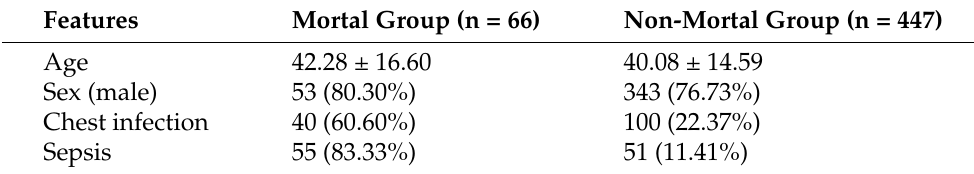
Table 4. Distribution of features in the mortal and non-mortal groups, number of patients, n = 513. Along with the features listed below, other multi-category features, such as diagnostic category, treatment phase, disease status, and type of microorganism in the bloodstream, were used to predict mortality. A total of 8 variables were used in the model to predict